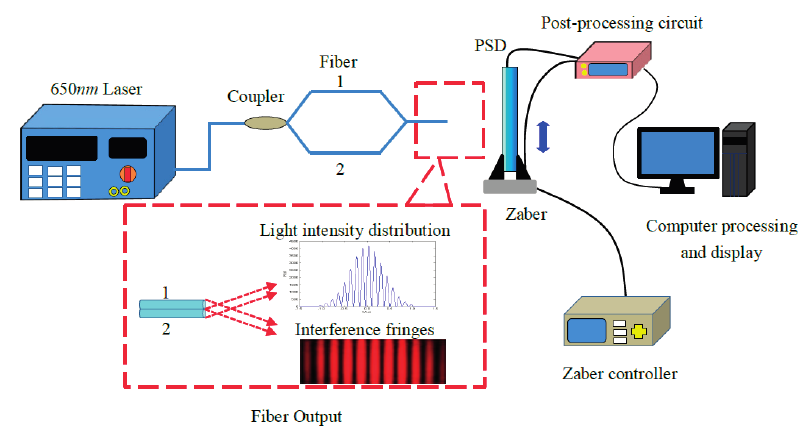
Figure 4. Experimental block diagram of measurement of fringes of displacement based on a single-mode fiber M-Z Space interferometer.